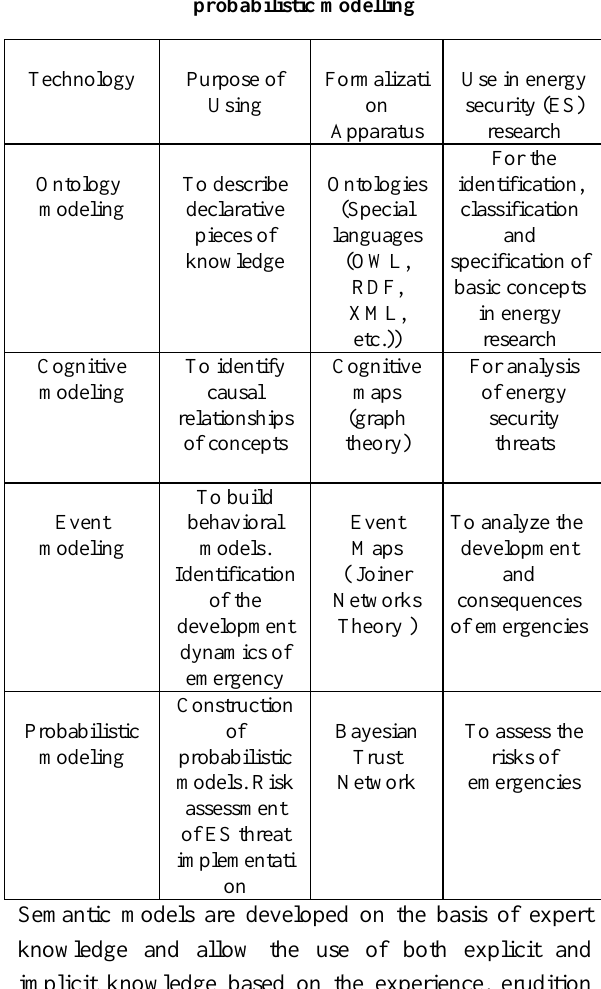
Table 1. Comparison of ontological, cognitive, event